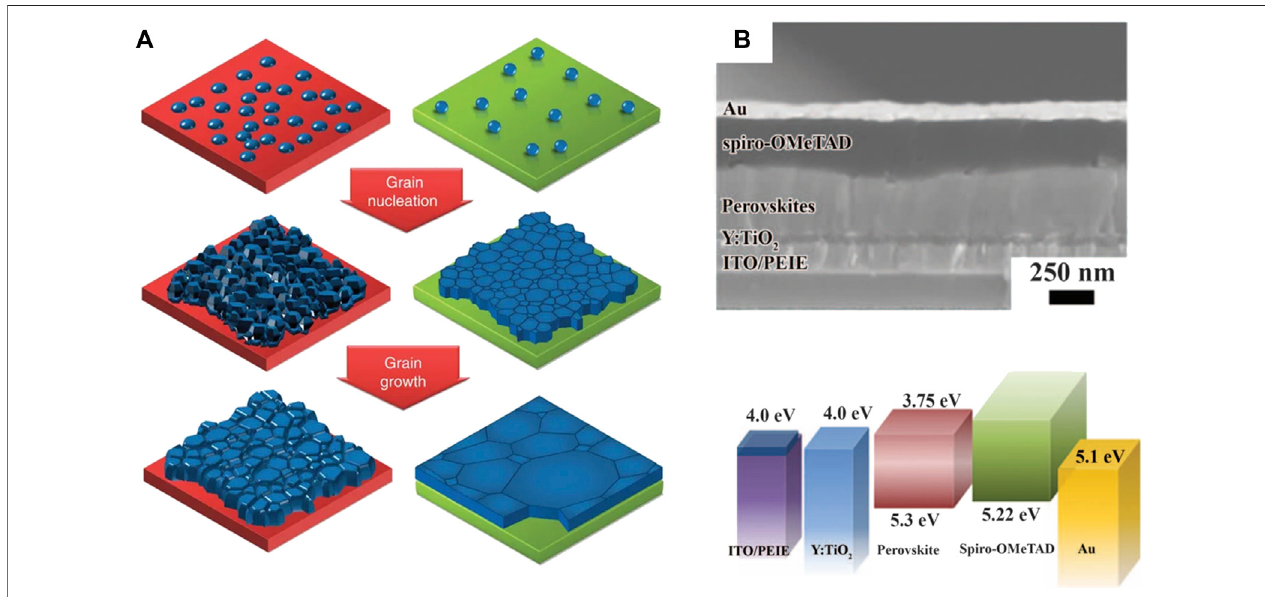
FIGURE4|(A) Thenucleationandgrowthofthegrainsonwettingandnon-wettingsurface.AdaptedfromBietal.(2015)withpermissionfromNaturespringer. (B) Device structure and energy levels of each functional layers in PSCs with PEIE interfacial modi fi cation. Reproduced from Zhou et al. (2014) with copyright from Science.